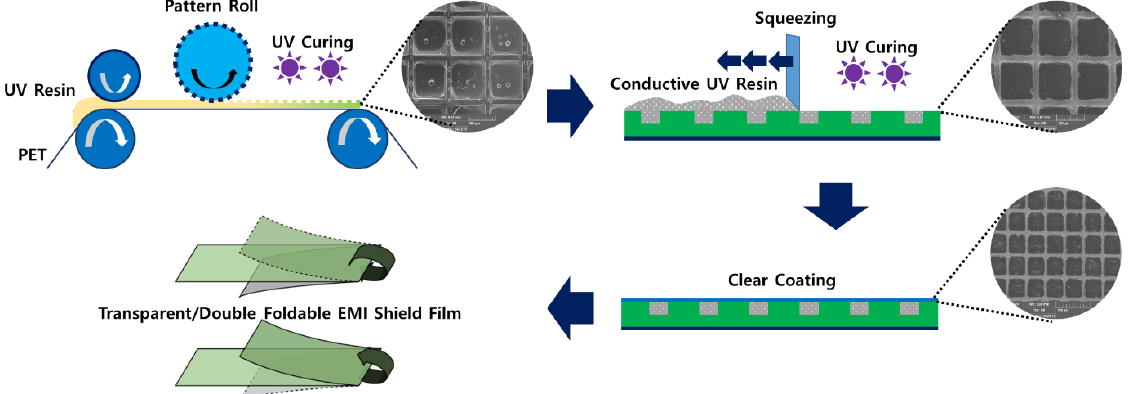
Figure 1. Schematic of the entire manufacturing process of a transparent and flexible electromagnetic interference (EMI) shielding film.